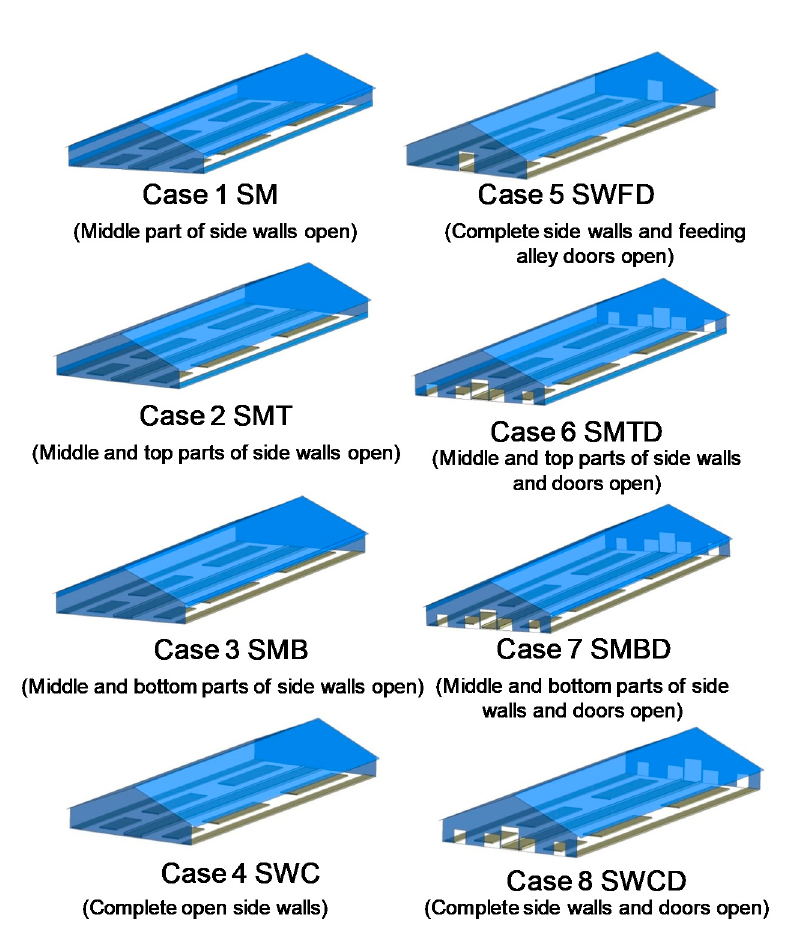
Figure 5. Eight cases with different geometrical opening scenarios of an NVD barn. The roof opening was kept open in all